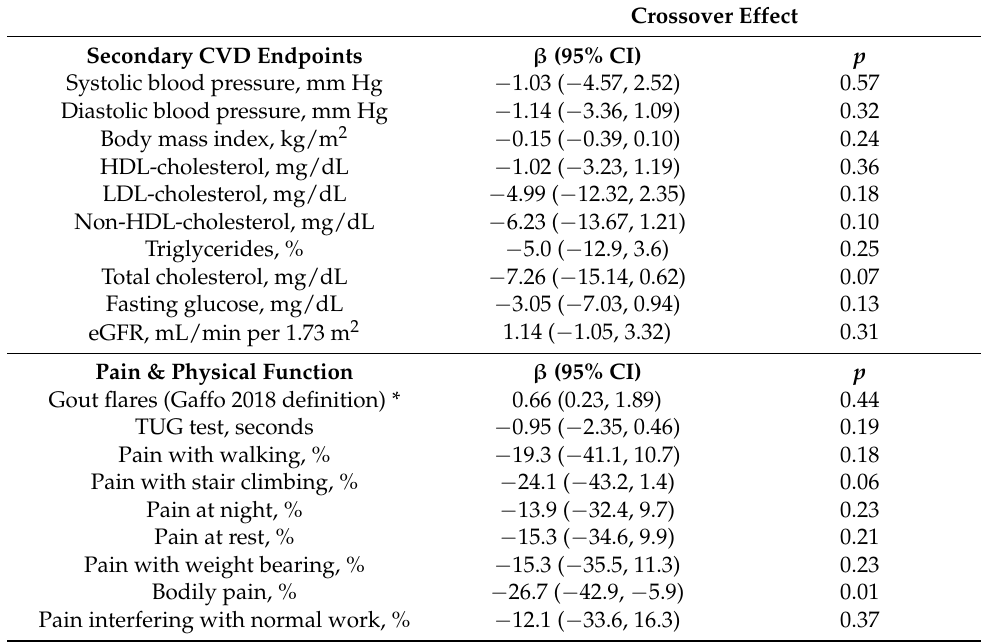
Table 3. Effects of Dietitian Delivered DASH versus Self-Directed Diet on Secondary Outcomes.